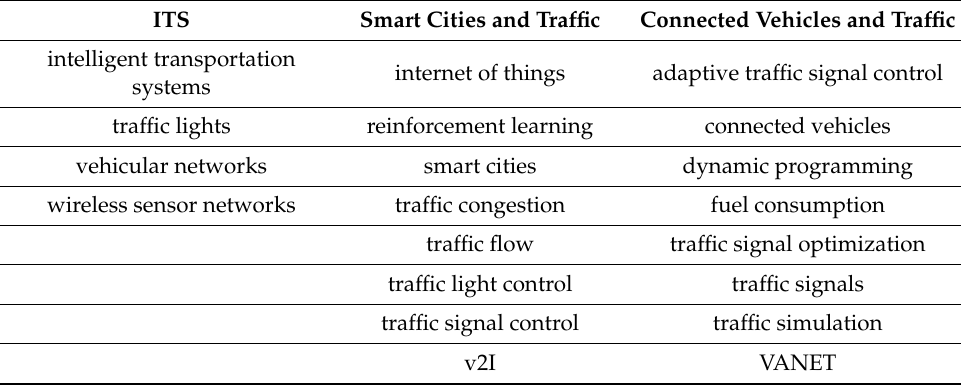
Table 1. Keyword topic visualization